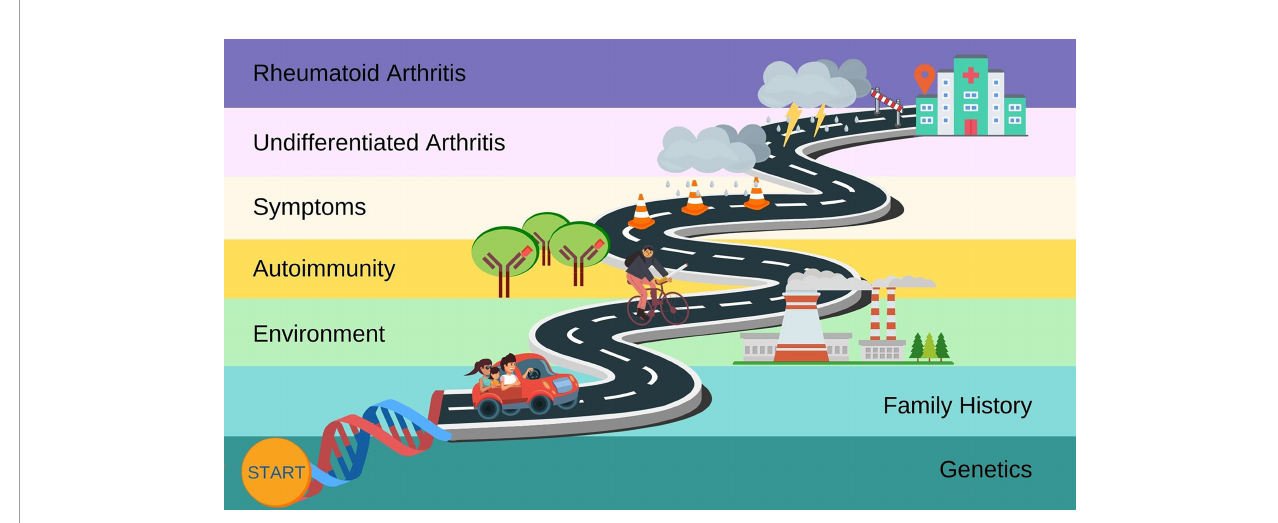
FIGURE 1 | Schematic illustrating the roadmap to the preclinical phases of rheumatoid